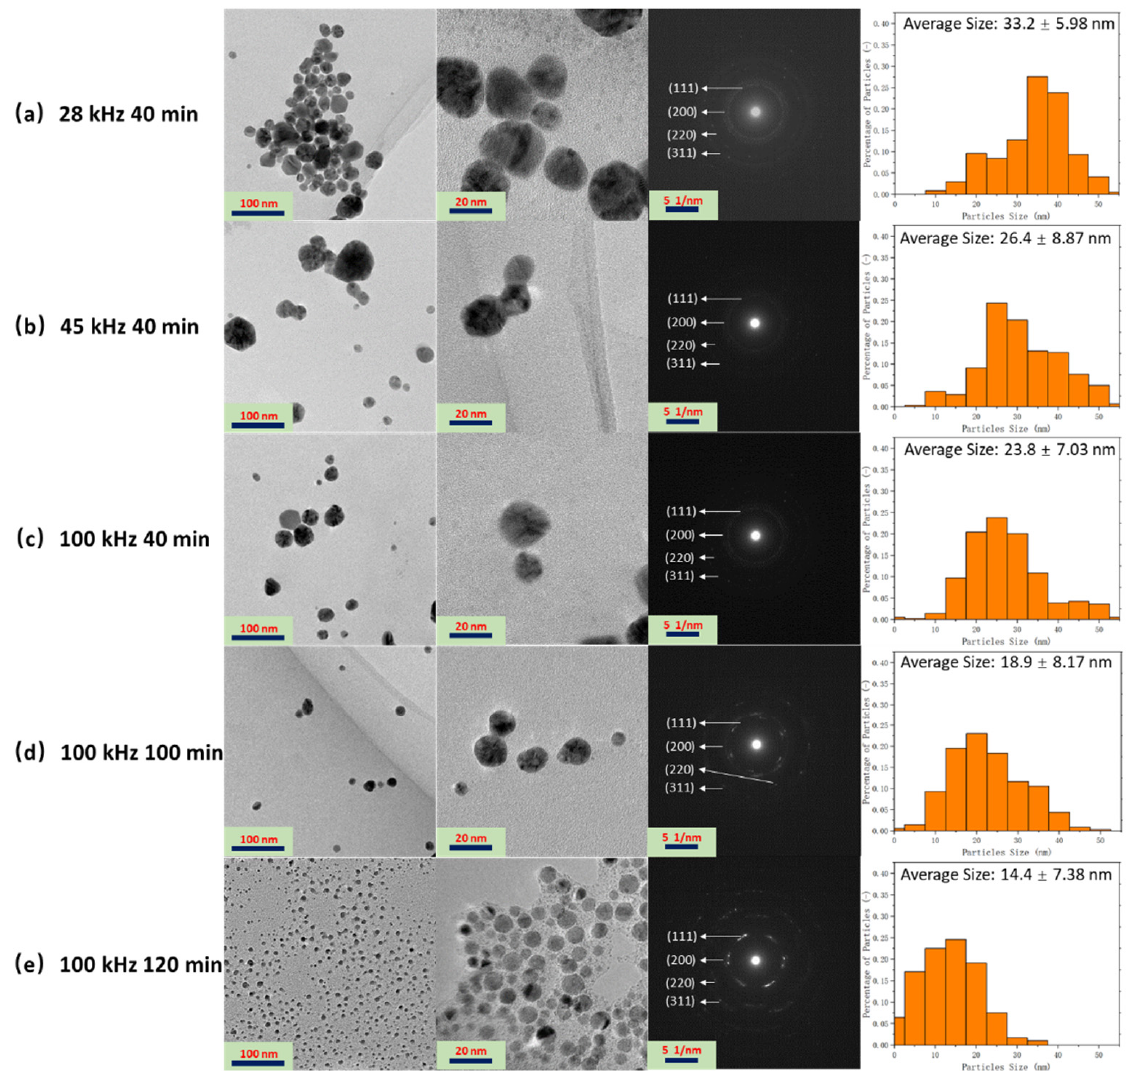
Figure 4. TEM images and SAED patterns of Ag NPs fabricated at different ultrasonic irradiation frequencies (28, 45, and 100 kHz) and durations (40, 80, and 120 min), ( a ) 28 kHz 40 min; ( b ) 45 kHz 40 min; ( c ) 100 kHz 40 min; ( d ) 100 kHz 100 min; ( e ) 100 kHz 120 min.